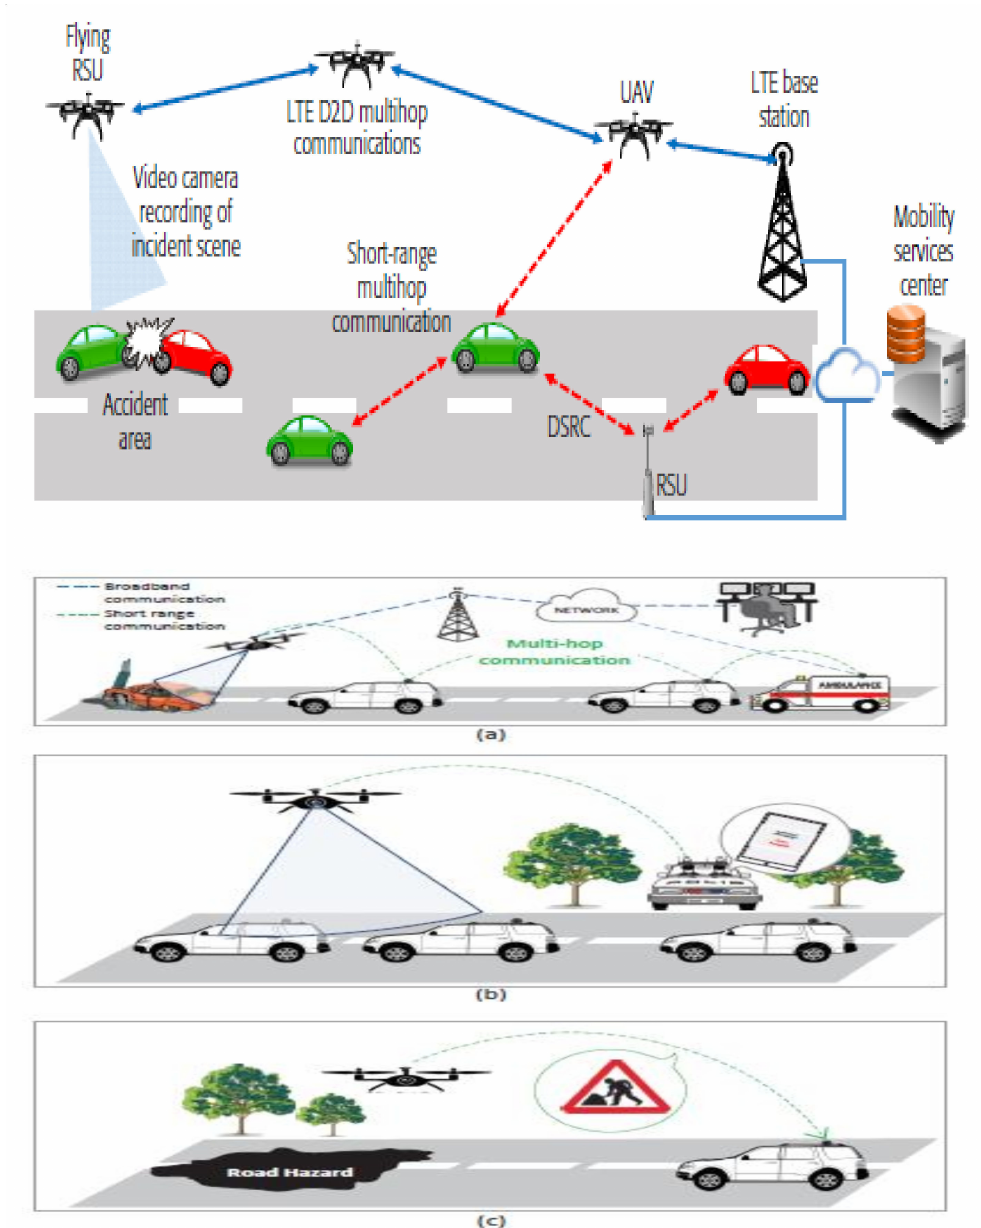
Figure 12. UAV smart transportation architecture [34]: ( a ) a UAV is exploited to provide the rescue team an advance report prior to reaching the incident scene; ( b ) Police exploits UAV to catch traffic violations; ( c ) a UAV is used as a flying RSU that broadcasts a warning about road hazards detected in areas devoid of an